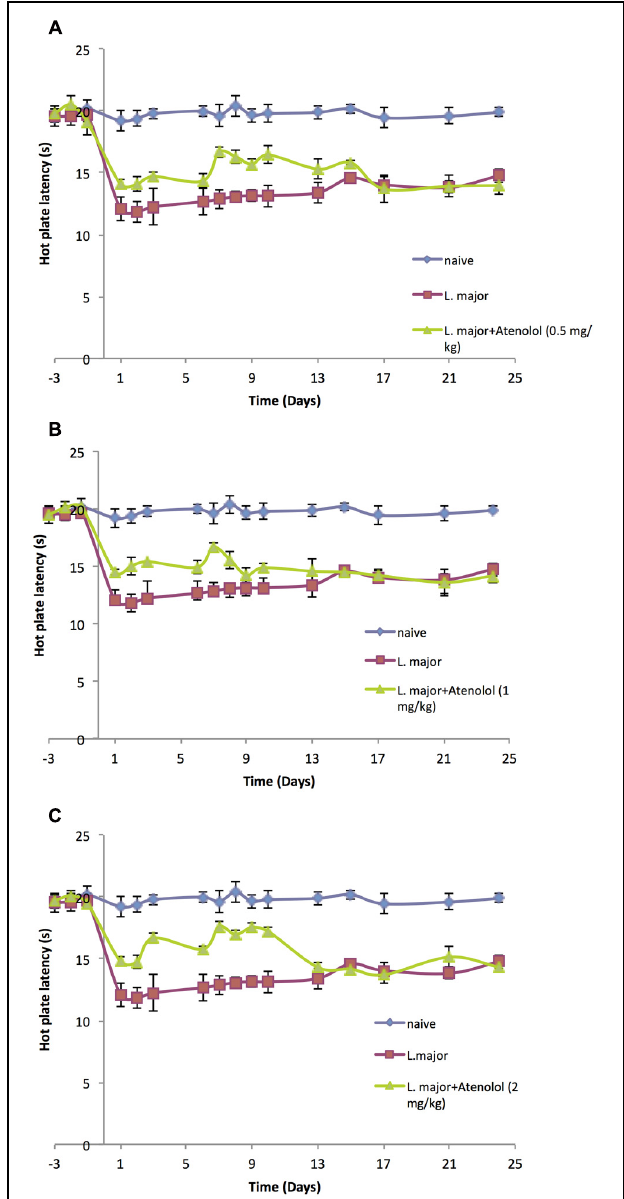
FIGURE 4 | The time course of the effect of the daily i.p. injection of atenolol on L. major (high dose) induced hyperalgesia as assessed by the HP Test. Mice were injected with 4 × 10 6 promastigotes per 50 μ l per left hind paw and three groups were also treated with Atenolol 0.5 mg/kg (A) , or 1.0 mg/kg (B) , or 2.0 mg/kg (C) for 7 consecutive days. Each result is the mean of 5 mice ± SEM and the degree of significance was calculated with reference to atenolol non-treated